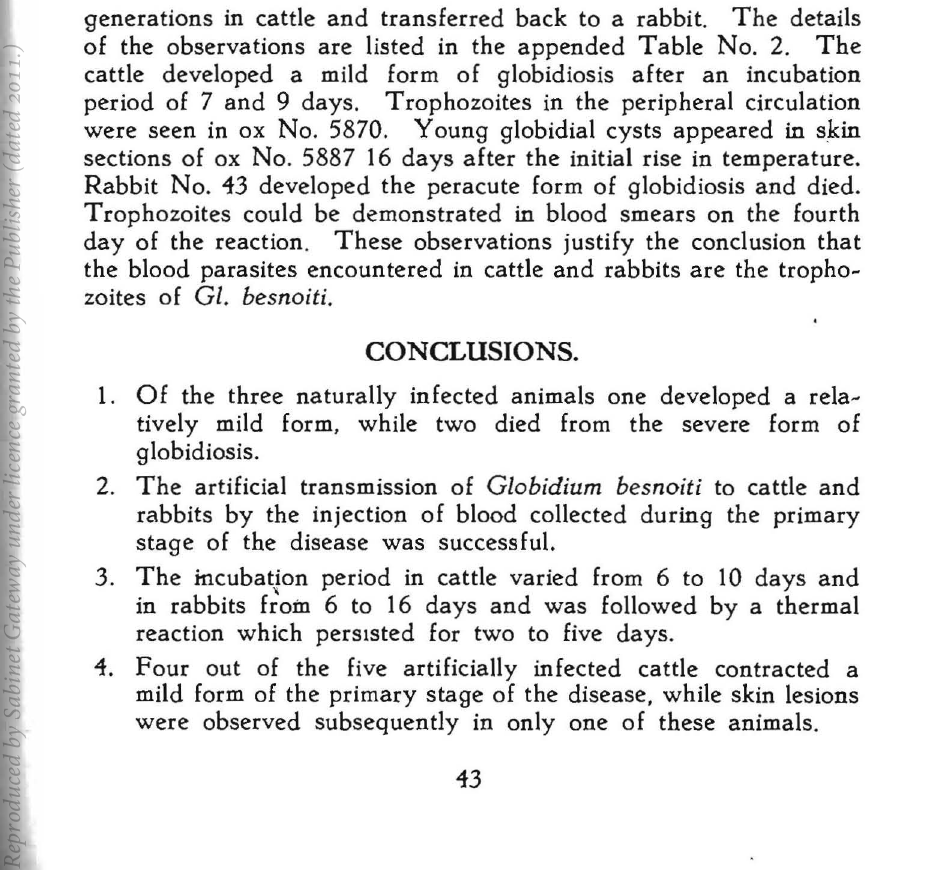
Fig. 4. Mature cysts in skin of heifer 6839 eight weeks after receiving a blood transfusion from Ox 6840. generations in cattle and transferred back to a